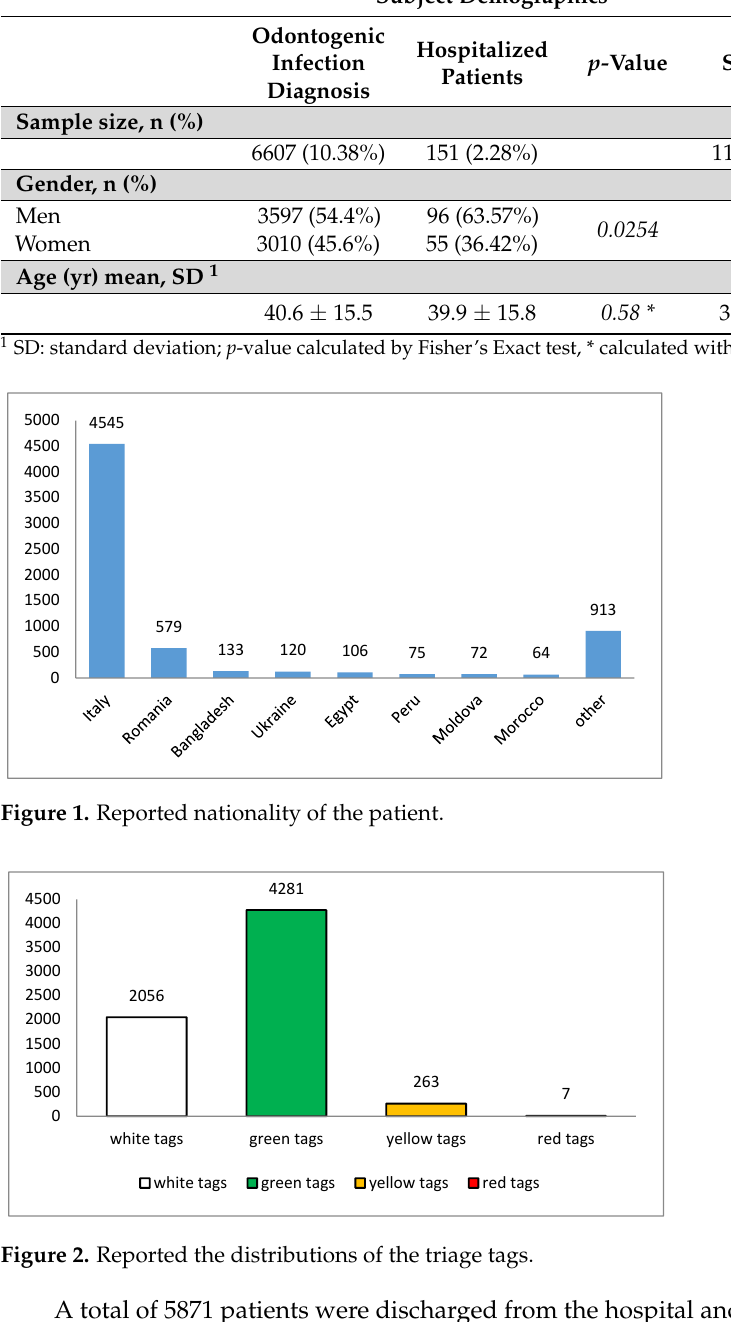
Table 2. Hospitalized patients: diagnosis and treatment.